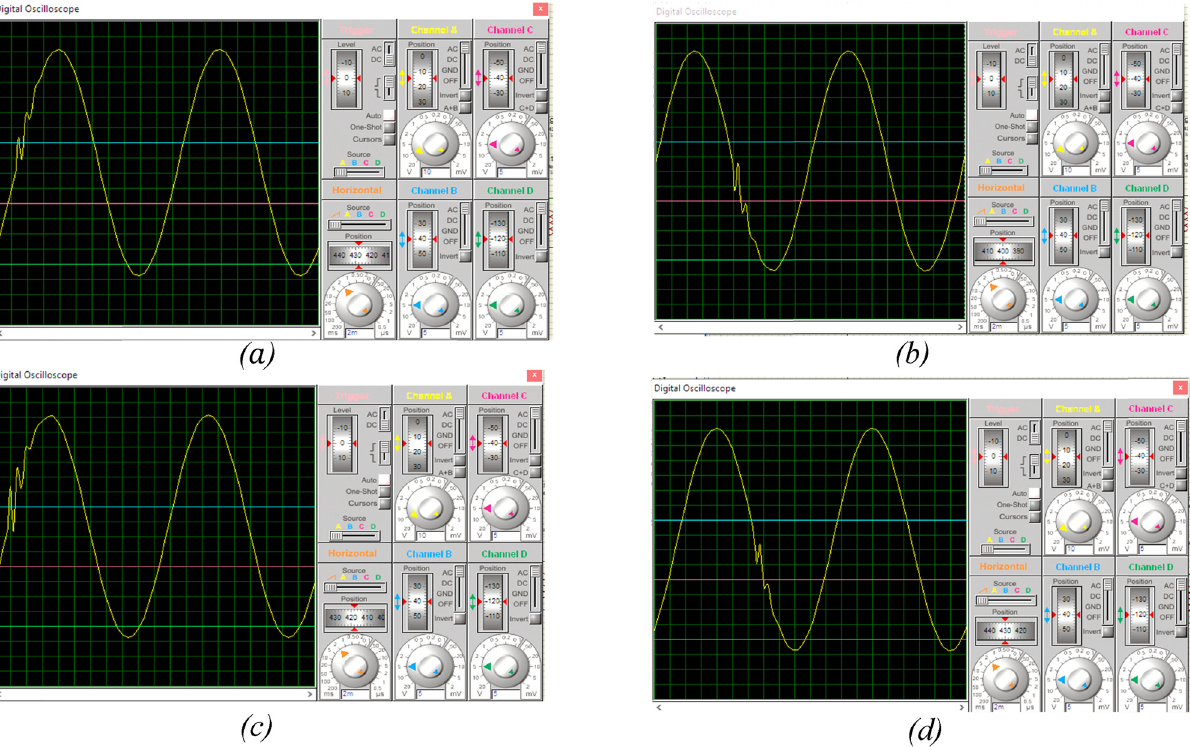
Figure 10: PD location. ( a ) PD hit due to C 1 . ( b ) PD hit due to C 2 . ( c ) PD hit due to C 3 . ( d ) PD hit due to C 4